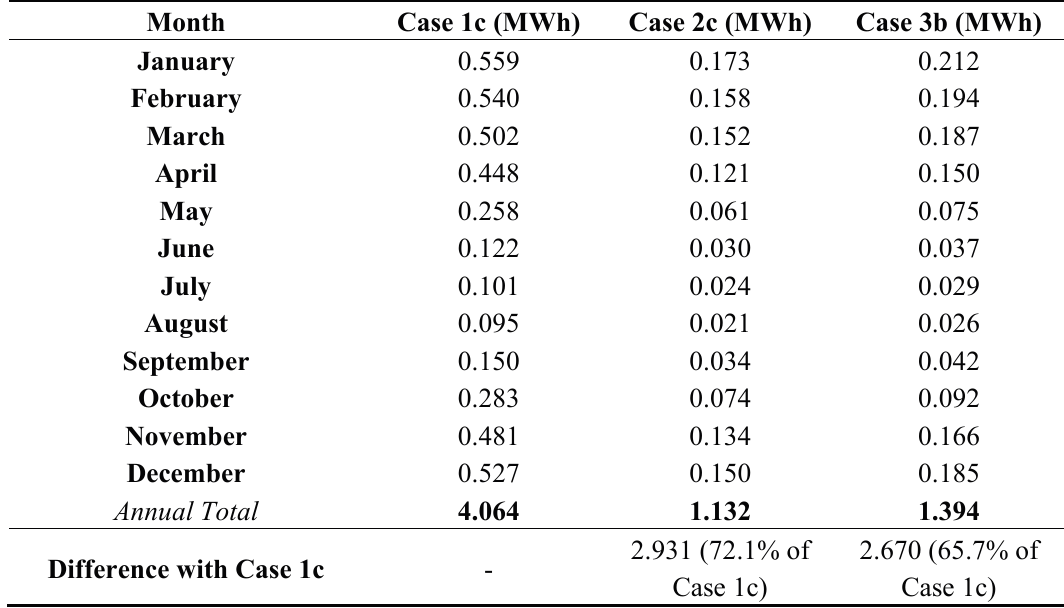
Table 4. Heating plant sensible